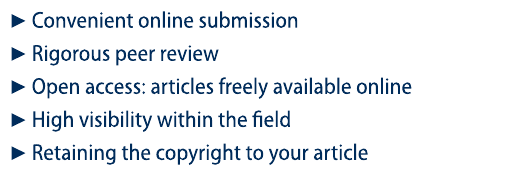
algorithm: application to classification of mass and normal breast tissue[J]. Med. Phys. 23 (10), 1671